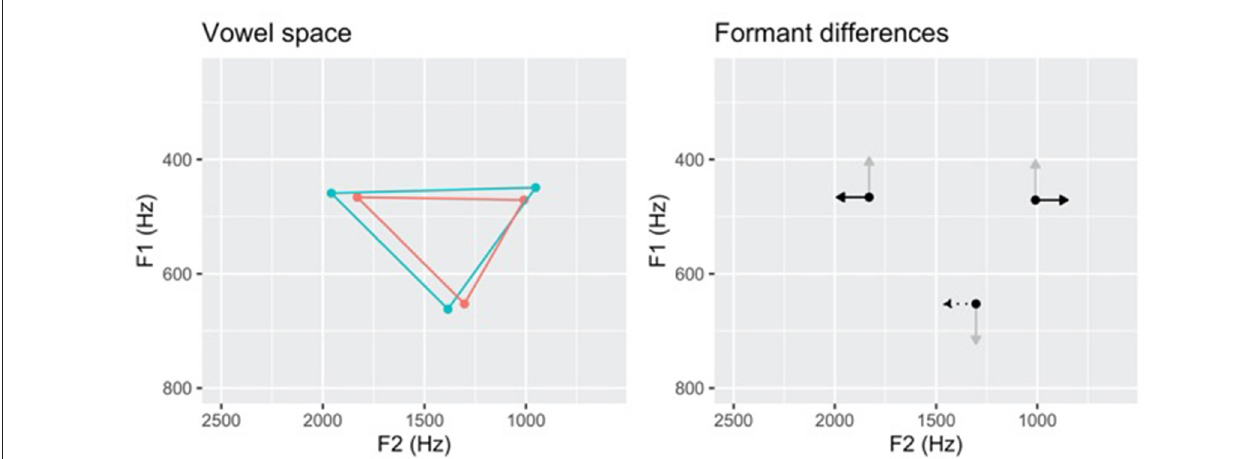
FIGURE 7 | Illustration of vowel space differences (left) and formant value differences (right). Black arrows signify differences where p < 0.05, gray arrows signify differences signify differences where p > 0.05. Solid lines indicate hyperarticulation in IDS relative to ADS, dotted line indicate hypoarticulation in IDS relative to ADS. Red lines show the vowel space for ADS and blue lines show the vowel space for IDS.